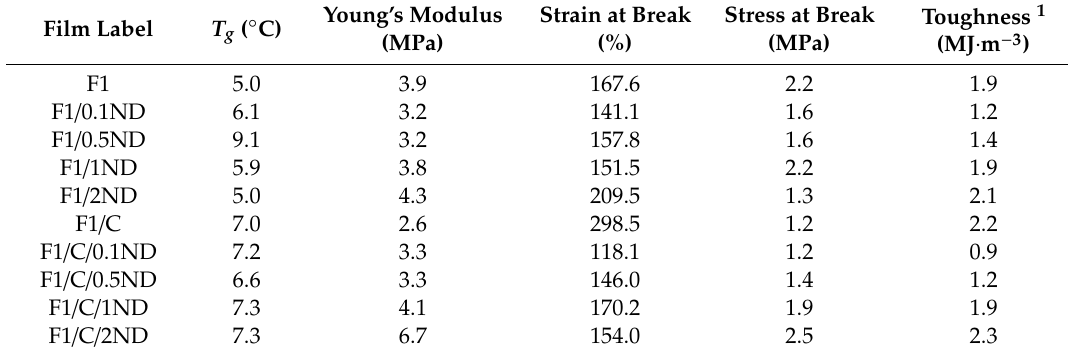
Table 2. Mechanical properties of the films.